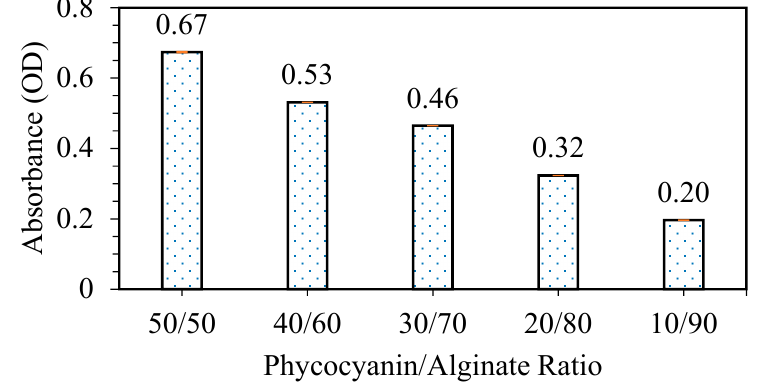
Figure 3. Elongation at break of patches with various phycocyanin / alginate ratios.